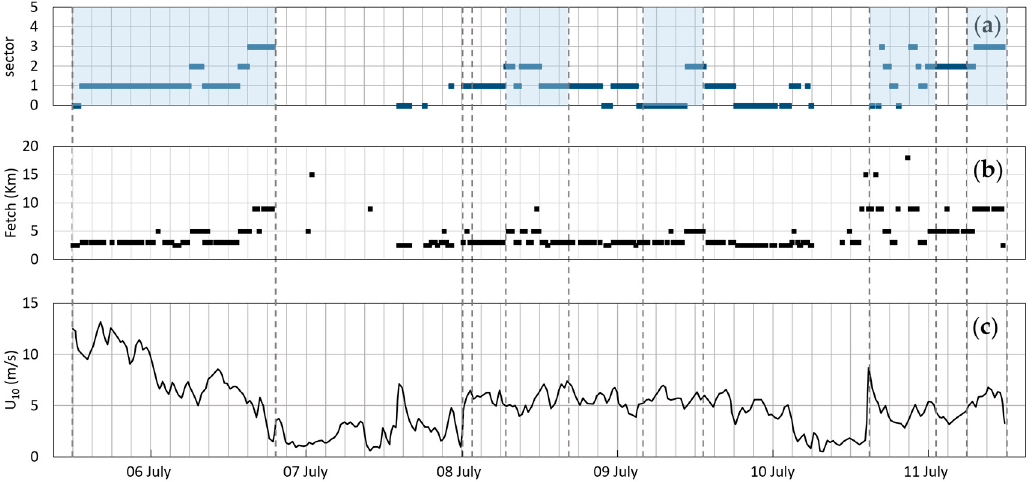
Figure 8. Wind data measured during the campaign of July 2005 [53]: ( a ) sectors of blowing winds; ( b ) the relative mean fetch according to the values in Table 3; ( c ) the wind speeds. The colored bands limited by the dashed lines correspond to the conditions of fully developed wave motion which satisfy relation (10).